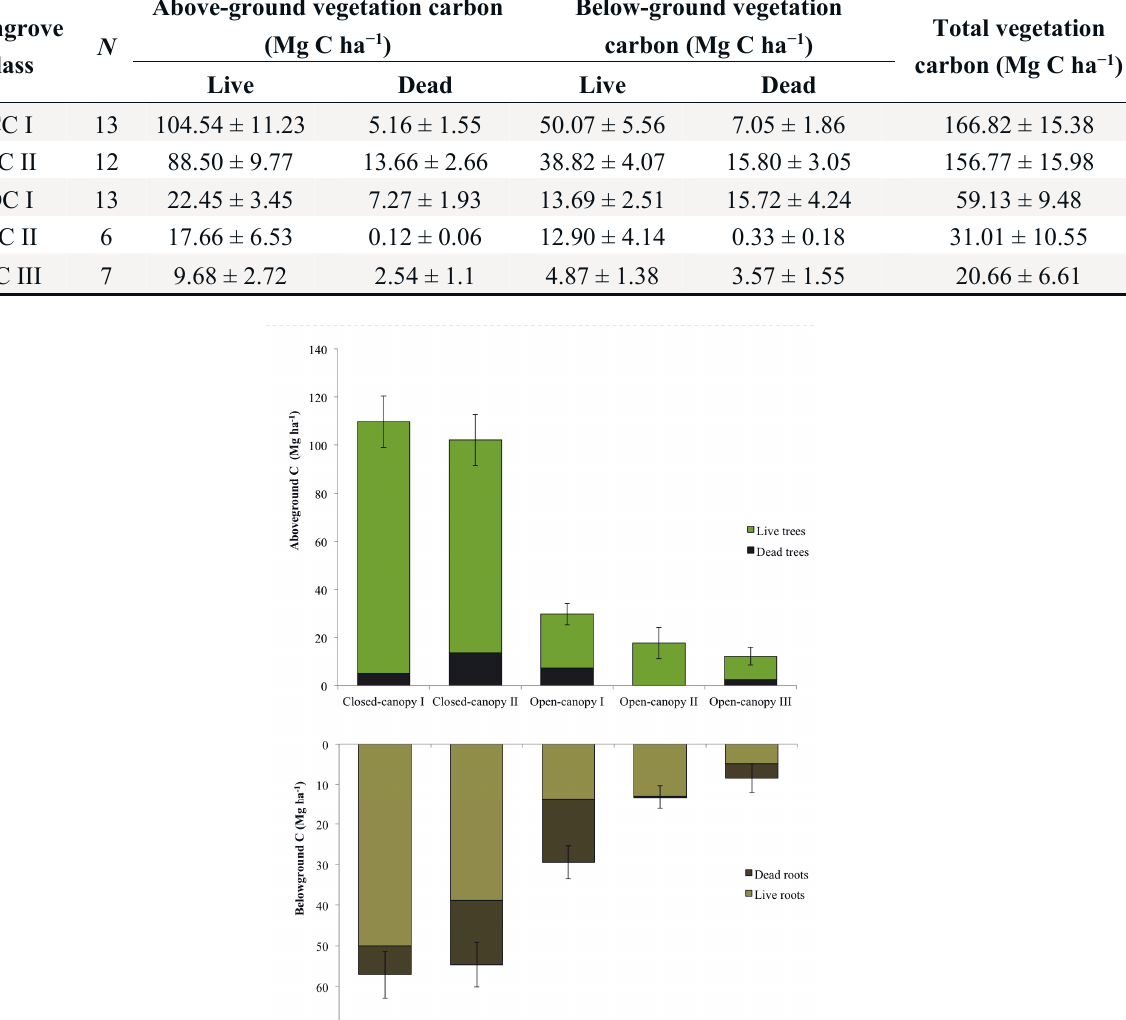
Figure 8. Above- and below-ground vegetation carbon stocks for each mangrove class in Mahajamba Bay. Error bars indicate ± SE. Note the varying scale of the y-axes above- and